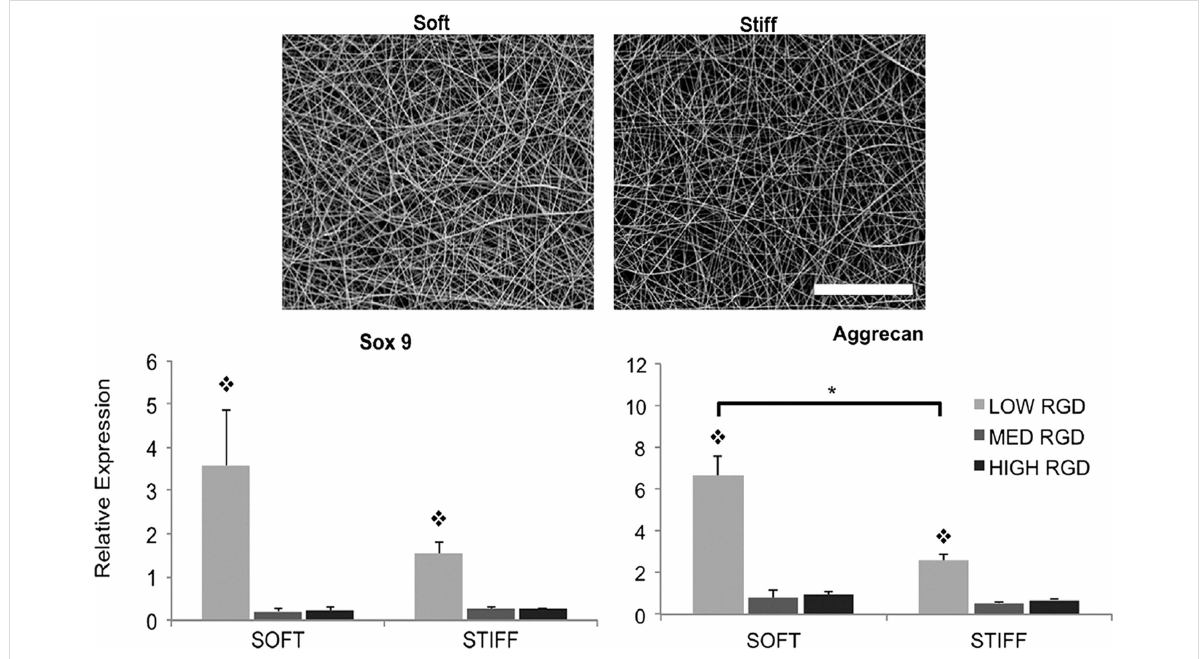
Figure 3: (Top) SEM images of electrospun nanofibers, representing the soft group (35% modified MeHA) and the stiff group (100% modified MeHA). (Bottom) Gene expression analysis of chondrogenic markers of hMSCs seeded on these scaffolds. RGD peptides in different concentrations were also used to enhance scaffold adhesivity. Figure 3 was reprinted from [8], Biomaterials, vol. 34, by I. L. Kim; S. Khetan; B. M. Baker; C. S. Chen; J. A. Burdick, “Fibrous hyaluronic acid hydrogels that direct MSC chondrogenesis through mechanical and adhesive cues”, pages 5571–5580, Copyright (2013), with permission from Elsevier. This content is not subject to CC BY